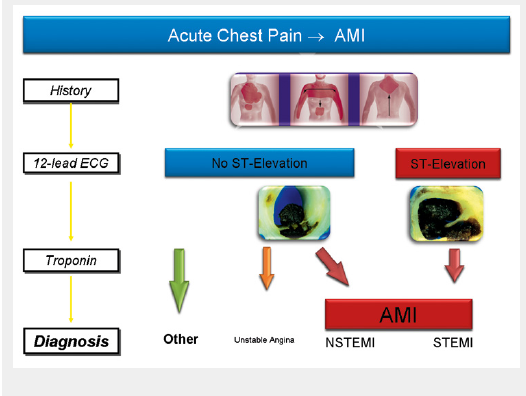
12-lead ECG and measurement of cardiac troponin complement clinical assessment in the diagnosis of acute myocardial infarction